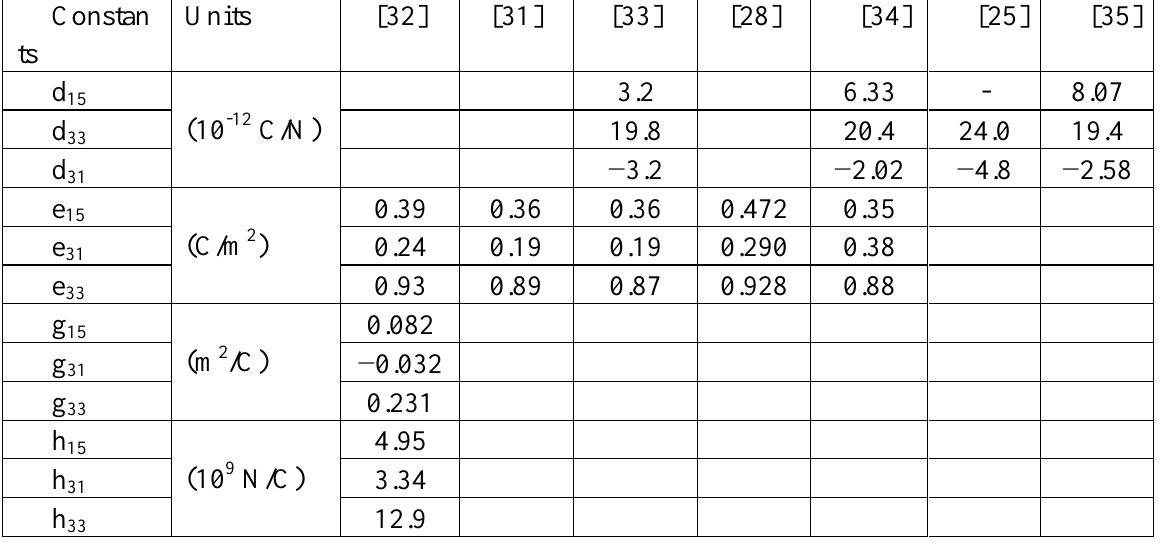
Table 1. A summary of the experimentally determined piezoelectric characteristics of Li B O single 2 4 7